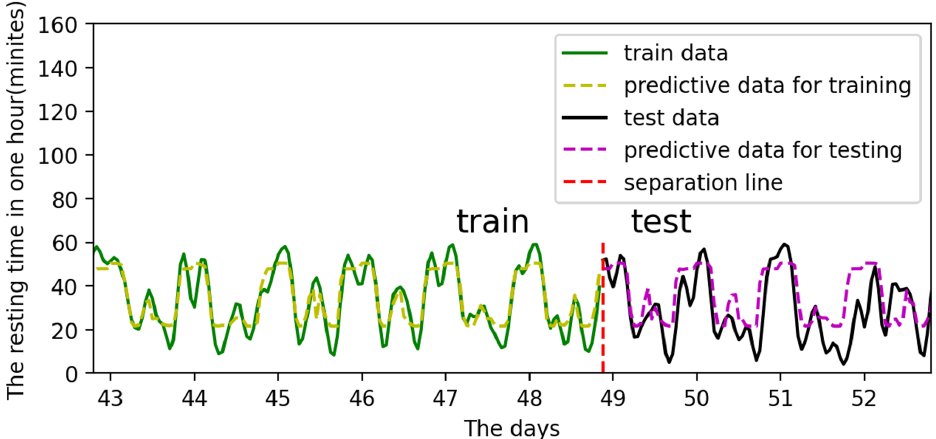
Figure 12. The predictive results after training and testing.